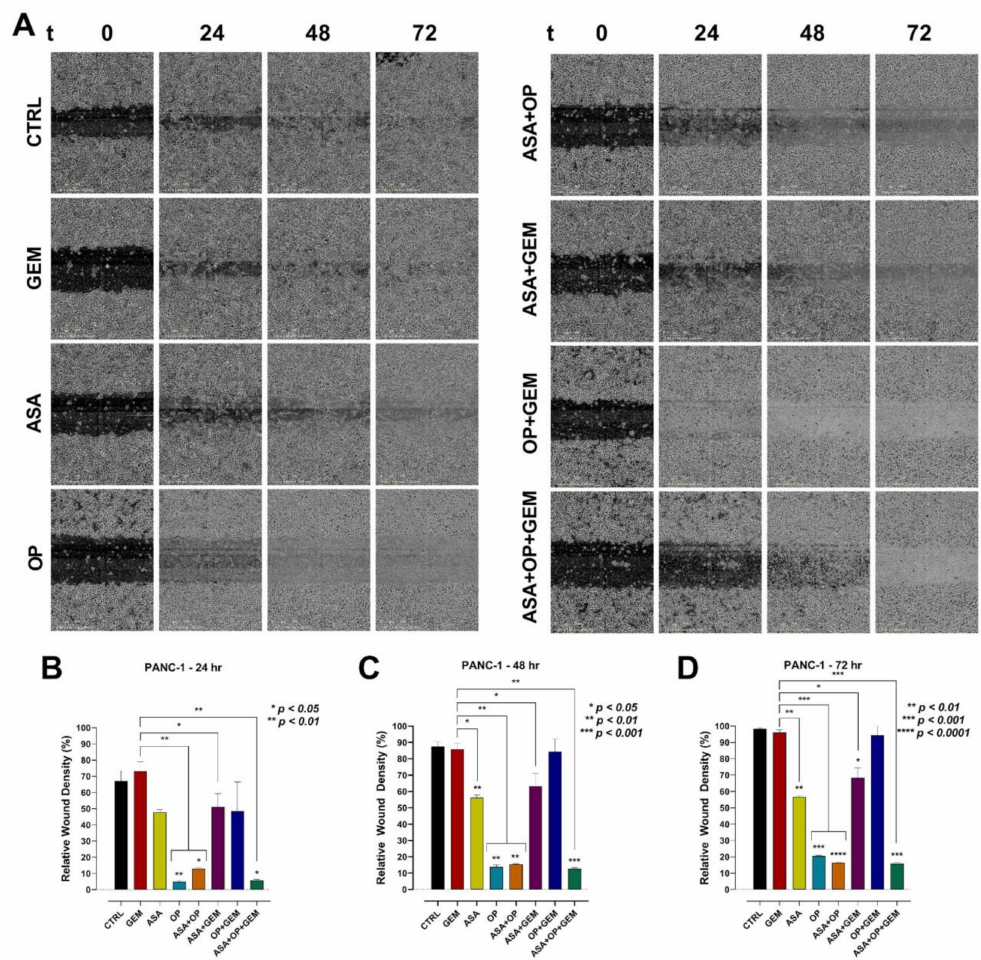
Figure 10. ASA, OP, GEM, and their combination inhibit wound closure of PANC-1 pancreatic cancer cells. PANC-1 cells were seeded in a flat bottom ImageLock™ 96-well plate and allowed to adhere overnight. The WoundMaker™ was used to create reproducible wounds in all wells. Unbound cells were washed, and cells were treated with ASA (4 mM), OP (4.7 mM), GEM (0.338 µ M), or their combination. ( A ) The IncuCyte ZOOM ® software was used to scan the plate repeatedly over 72 h. The wound migration area was quantified using the IncuCyte ZOOM ® software comparing the wound density at ( B ) 24 h, ( C ) 48 h, and ( D ) 72 h to the immediate wound density. The data are presented as relative wound density ± SEM of 3 independent experiments performed in triplicates. Significance is shown compared to the CTRL unless otherwise shown, using the one-way ANOVA Fisher test comparisons with 95% confidence with indicated asterisks for statistical